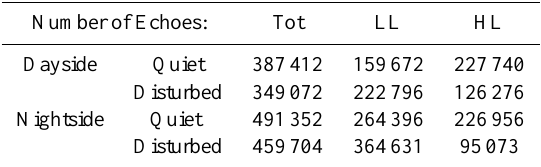
Table 3. Number of echoes for Quiet and Disturbed Is depending on MLT and Magnetic Latitude. Dayside extends from 06:00 to 18:00 MLT, nightside extends from 18:00 to 06:00 MLT. LL stands for Low Latitude (60 ◦ − 70 ◦ 3 ), while HL stands for High Latitude (70 ◦ − 80 ◦ 3